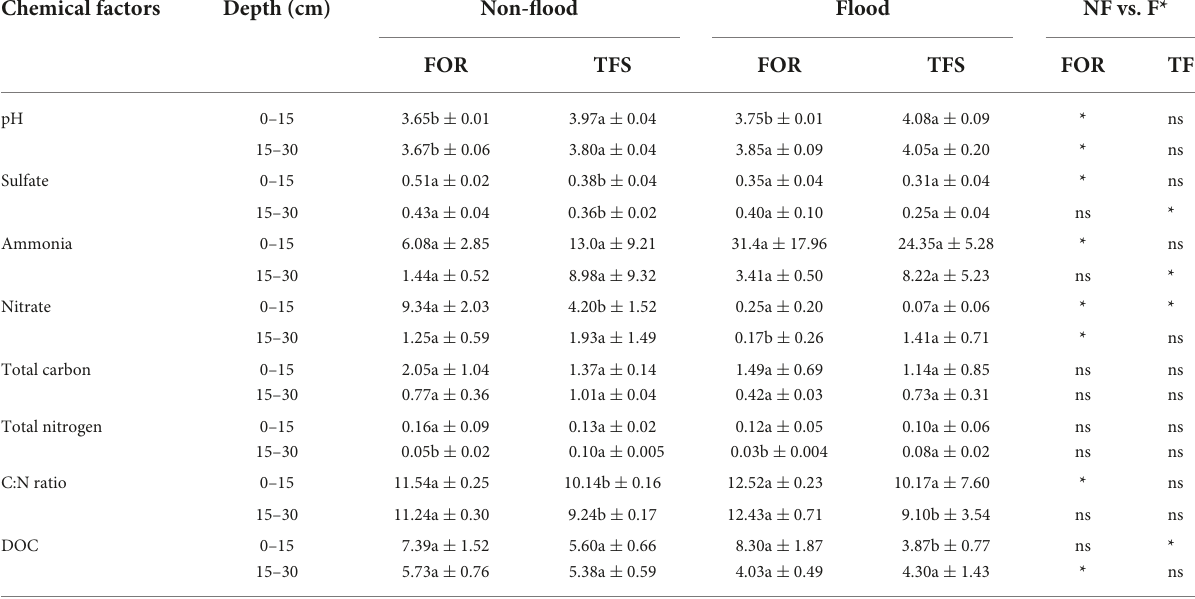
TABLE 1 Chemical attributes of the soil samples at each depth (0–15 and 15–30 cm), site [Forest (FOR) and Agroforest (TFS)], and season [Non-flood (NF) and Flood (F)] in the Tocantins River plain.